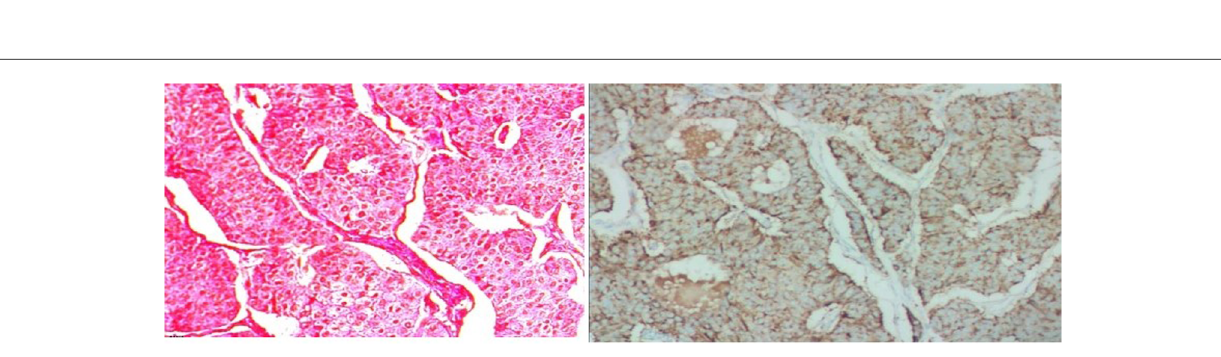
FIGURE 3 Histology of PHNET. The tumor cells with consistent size arranged as solid nests, funicular, gland-like structure, and blood sinus was rich in the nests among neoplastic cells; their abundant cytoplasmic with pinky color, and the borders of the tumor cells were clear. Tumor cells were round or ovoid nuclei and slightly enlarged, dark cell nucleus and light cell cytoplasm, lower mitotic rate. A clear demarcation between the tumor and surrounding liver tissue was observed. PHNET, primary hepatic neuroendocrine